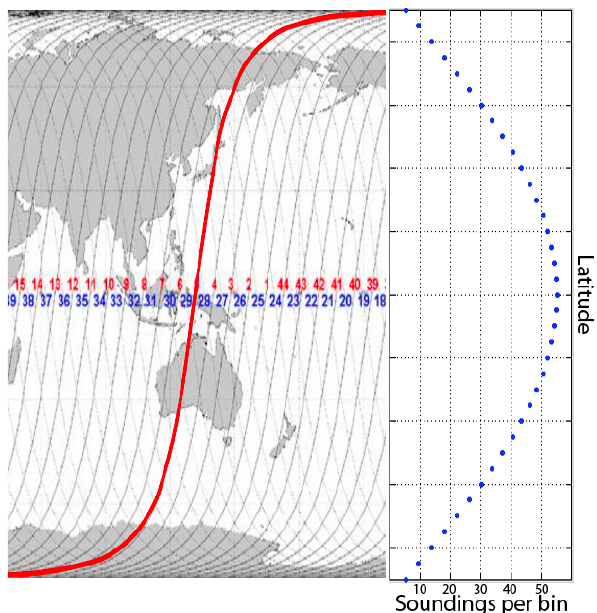
Figure 6. On the left, a sample GOSAT track, used with permission from the GOSAT path 2 Fig. 6. On the left, a sample GOSAT track, used with permission calendar. The sounding selector would be applied to this track individually, with a user-3 from the GOSAT path calendar. The sounding selector would be specified fraction of the soundings selected for processing. On the right, an example 4 applied to this track individually, with a user-specified fraction of distribution for the user-specified number of soundings per latitude bin desired. 5 the soundings selected for processing. On the right, an example dis- tribution for the user-specified number of soundings per latitude bin desired.